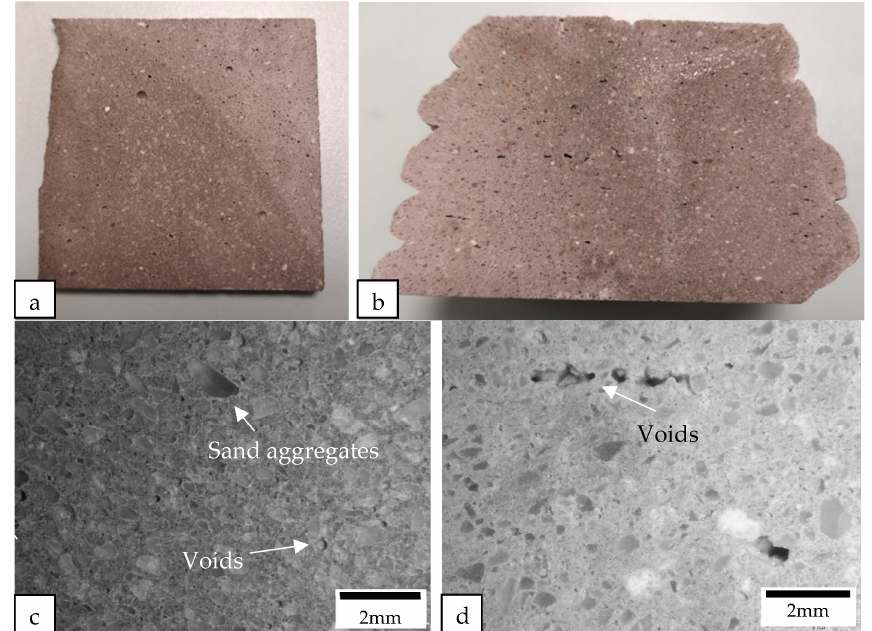
Figure 12. Cross-sectional images of ( a ) the cast control sample and ( b ) the printed control sample were obtained using a camera, while the macrostructure of the cross sections of ( c ) the cast control sample and ( d ) the printed control sample were examined under a microscope.